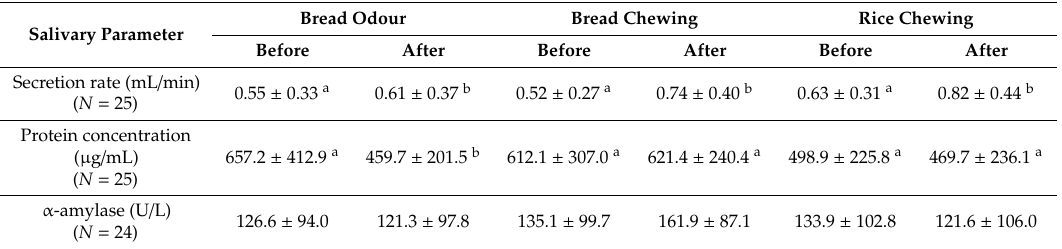
Table 1. Variations in different salivary parameters induced by the odour or mastication (values are presented as mean ± standard deviation).